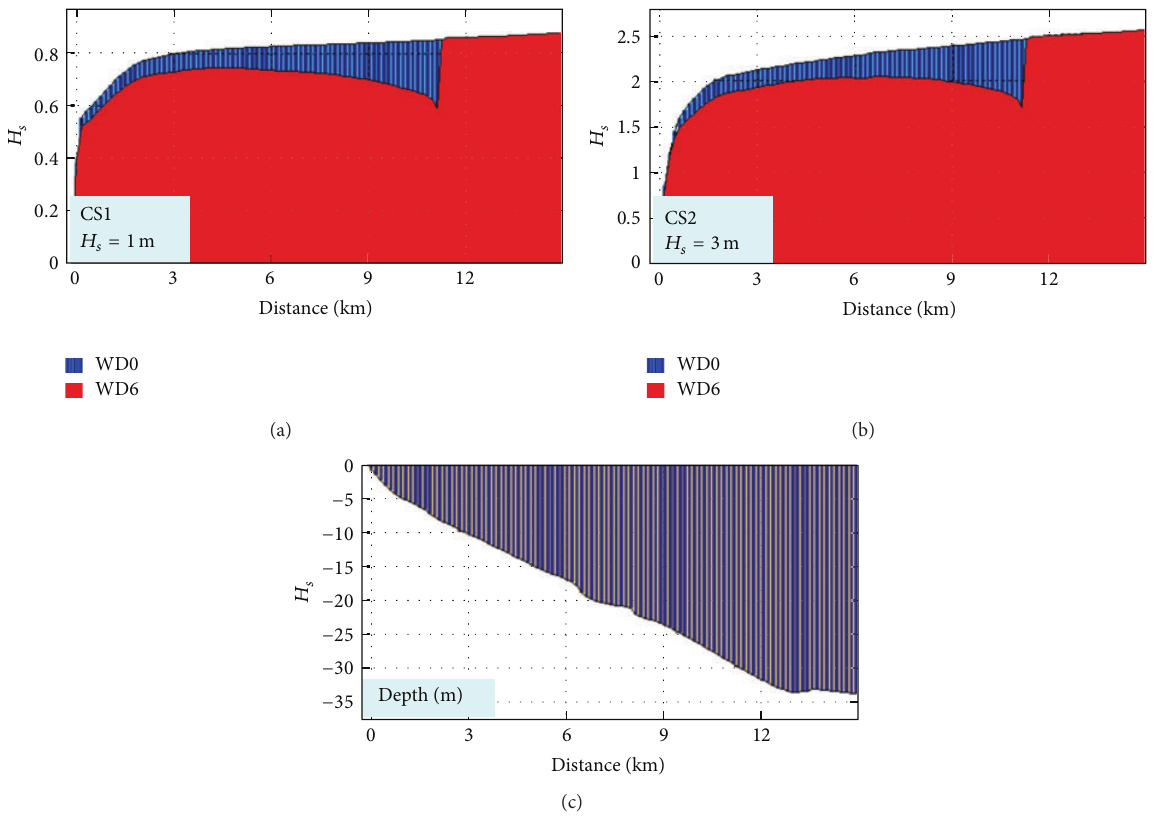
Figure 14: 𝐻 𝑠 variation along the reference line 3 without and with WD farm (WD0, WD6) for the two cases considered (CS1, CS2) and the variation of the water depth along the reference line.